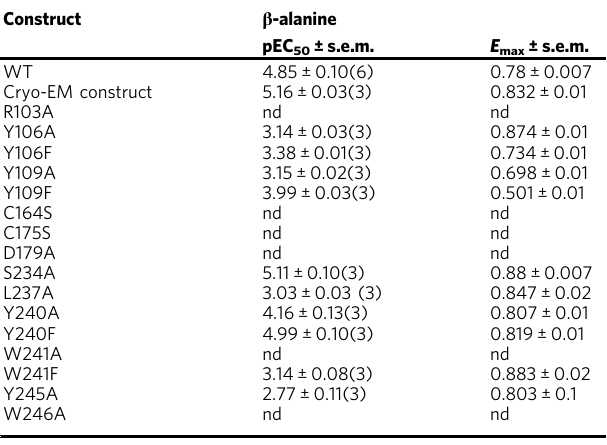
Table 2 NanoBiT G protein dissociation